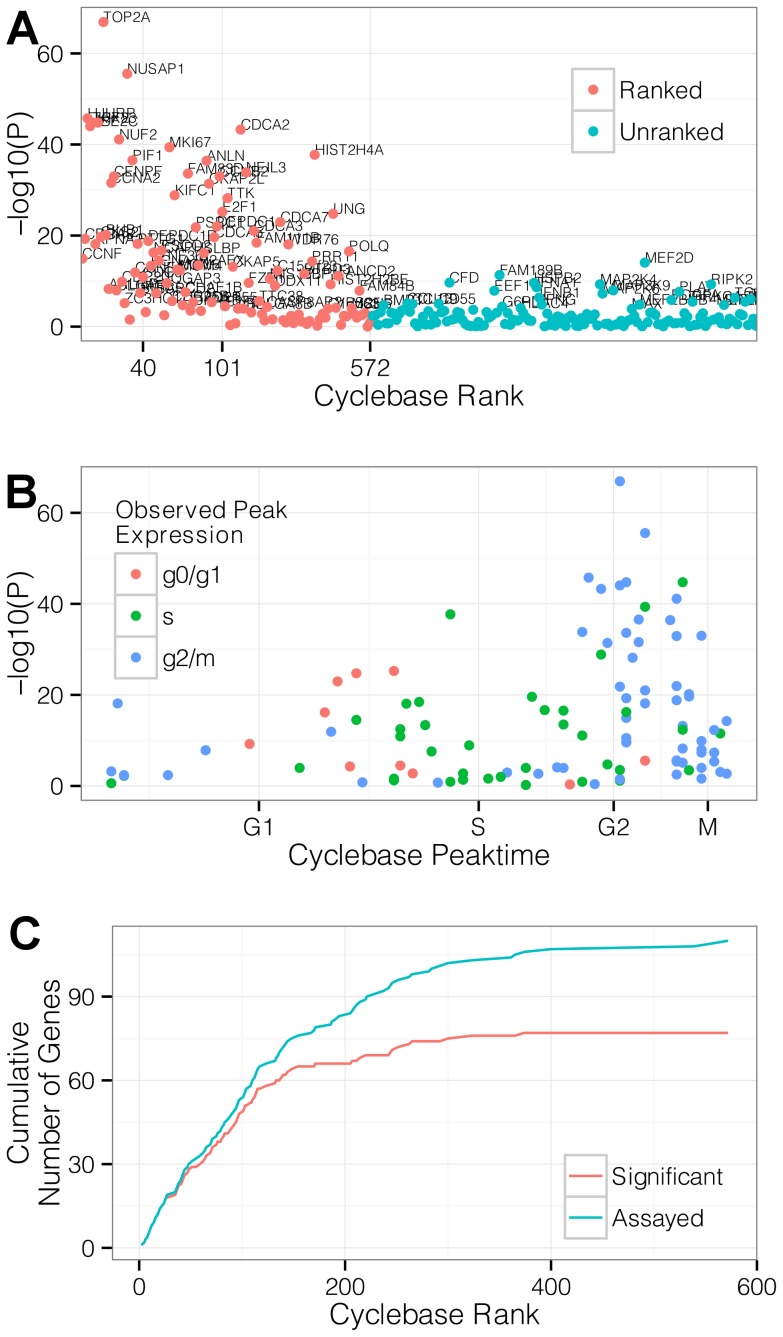
The Hurdle model identifies genes with cell cycle phase-dependent expression.(A) Hurdle model strength of evidence of cell cycle phase dependent expression for genes within our panel versus Cyclebase rank. P-values (-log10(p)) are shown on the y-axis. Ranked genes (red) are ordered on the x-axis according to Cyclebase rank. Unranked genes (blue) appear in alphabetical order. Genes significant after Bonferroni adjustment are annotated with their names (B) Hurdle model strength of evidence of cell cycle phase dependent expression in ranked genes versus phase of peak expression estimated from bulk data in Cyclebase. Experimentally observed peak times broadly match the times estimated from bulk data. Concordance in observed peak times is greater for genes with stronger evidence of differential expression. (C) Cumulative number of significant (red) or all (blue) ranked genes versus Cyclebase rank. Genes with lower Cyclebase rank, and hence stronger evidence of cycle regulation in bulk expression, are detected more often than genes with weaker evidence as shown by the minimal gap between significant (red) and all (blue) ranked gene lines at Cyclebase rank <150.